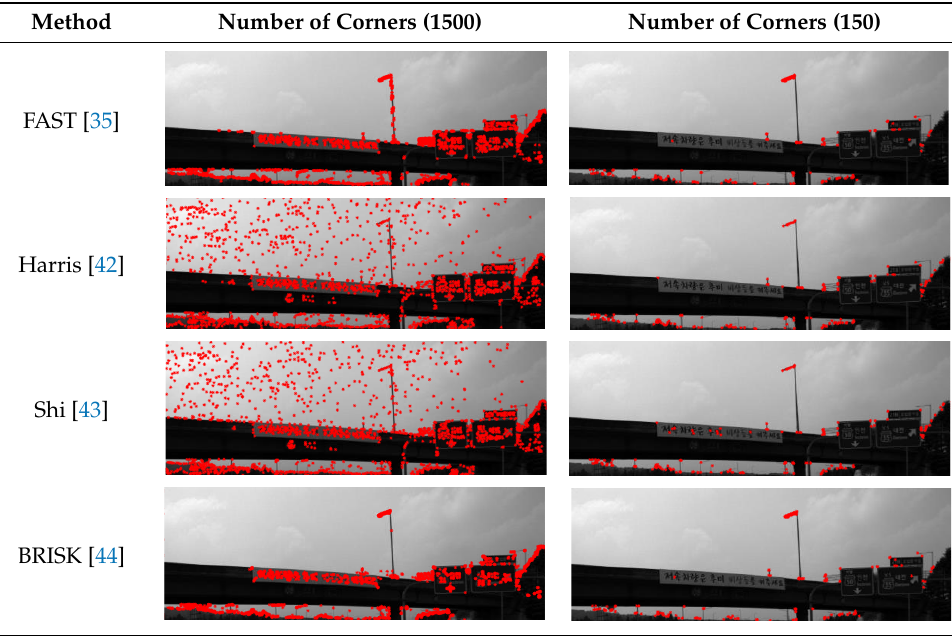
Table 1. Comparison of general corner detectors.